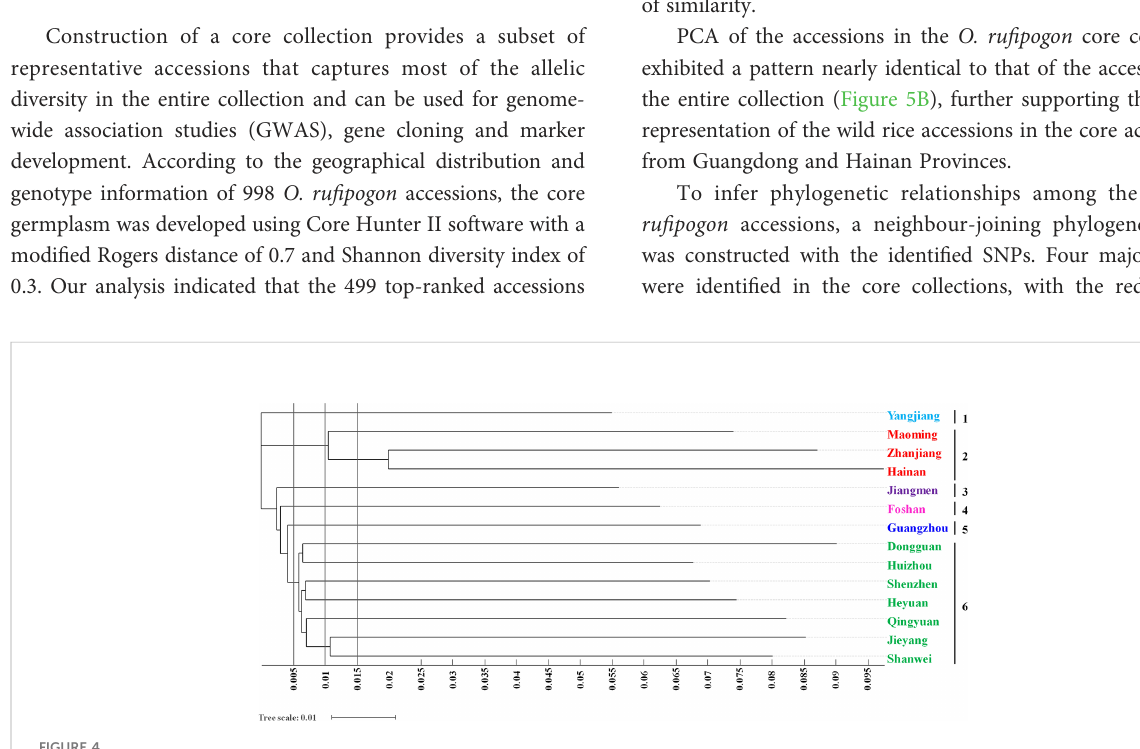
FIGURE 4 Dendrogram of O. ru fi pogon accessions in Guangzhou and Hainan using the NJ method. Different colours depict the population generated by the structure